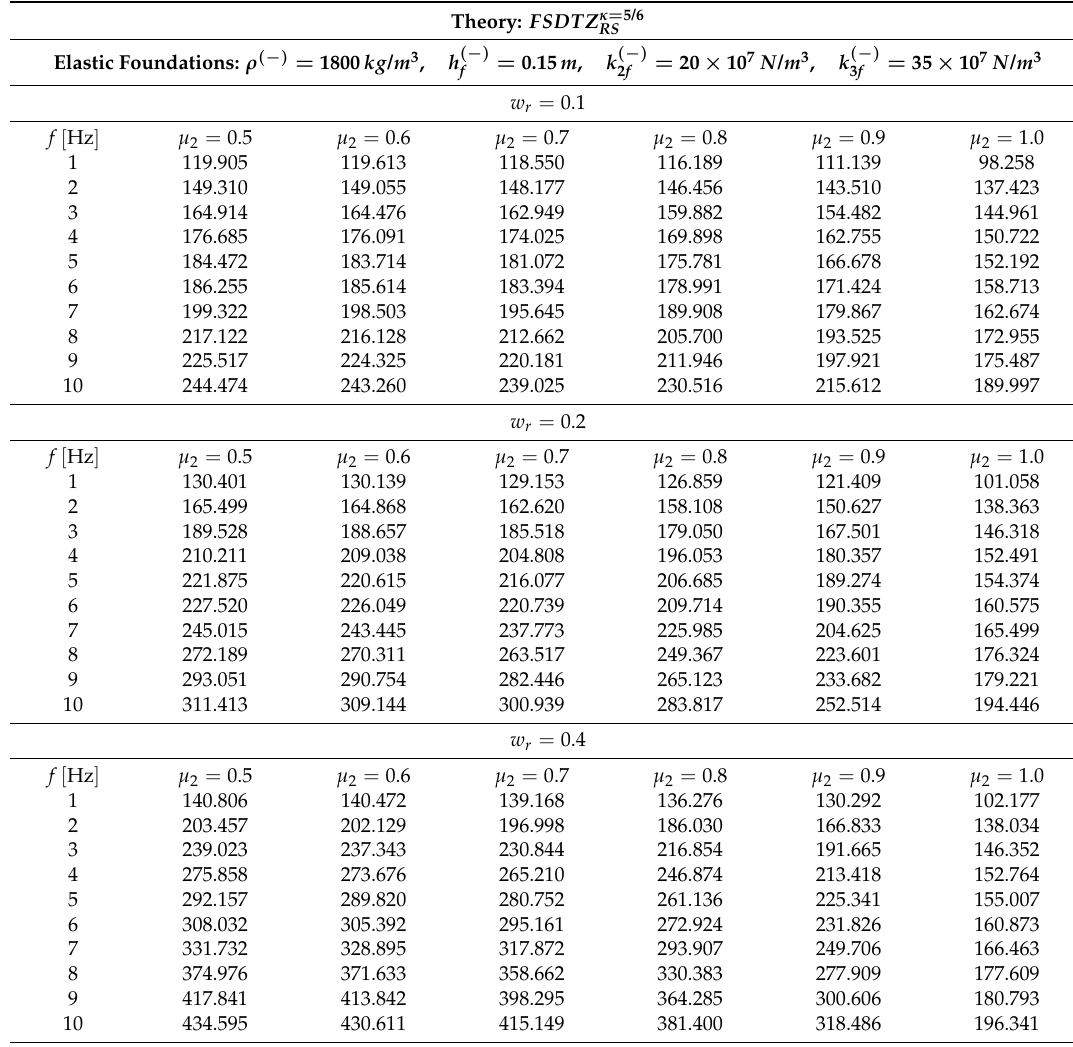
Table 17. First ten natural frequency variations for FSDTZ κ = 5/6 (Figure 4c) reinforced by CNTs distributed as in Figure 5c for different mass fractions w r when varying the parameter of agglomeration µ 2 with µ 1 = 0.5. The Chebyshev-Gauss-Lobatto grid distribution was employed, with I N = 31, I M =